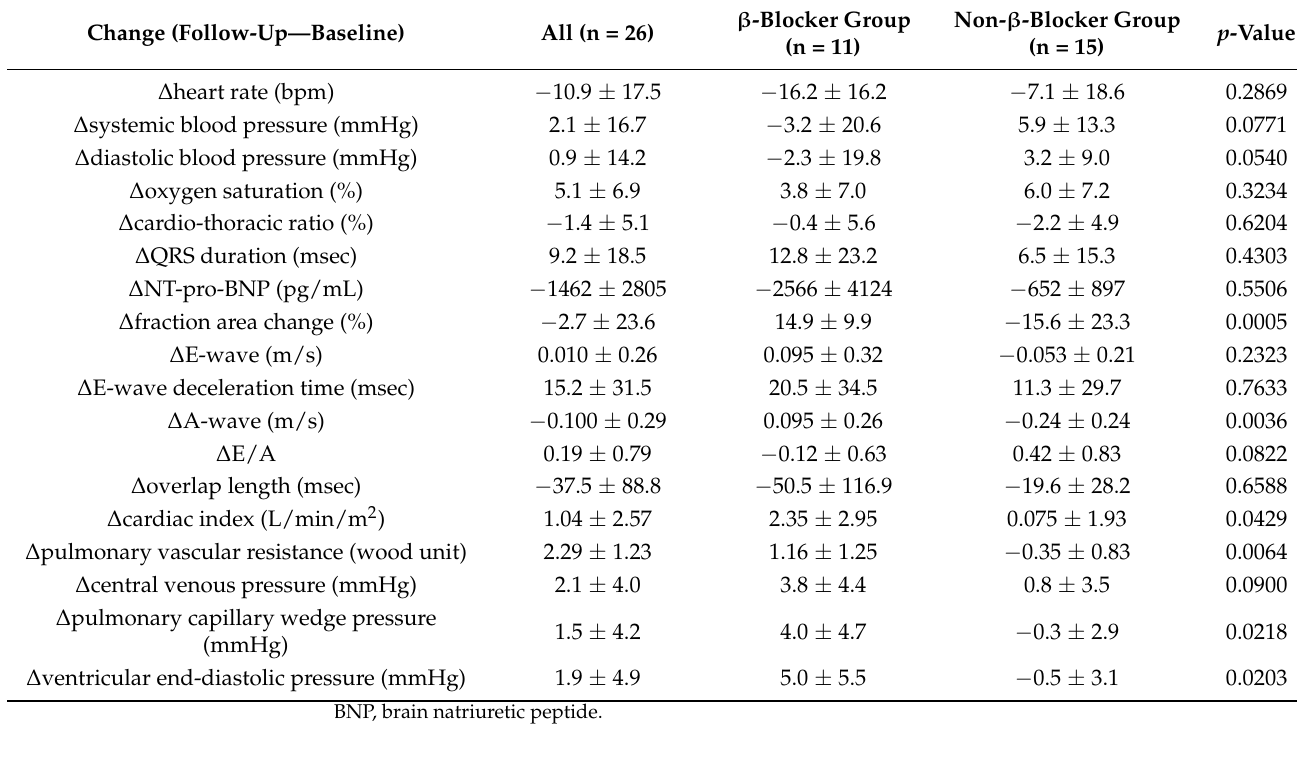
Table 3. Amount of change in variables between baseline and follow-up data.